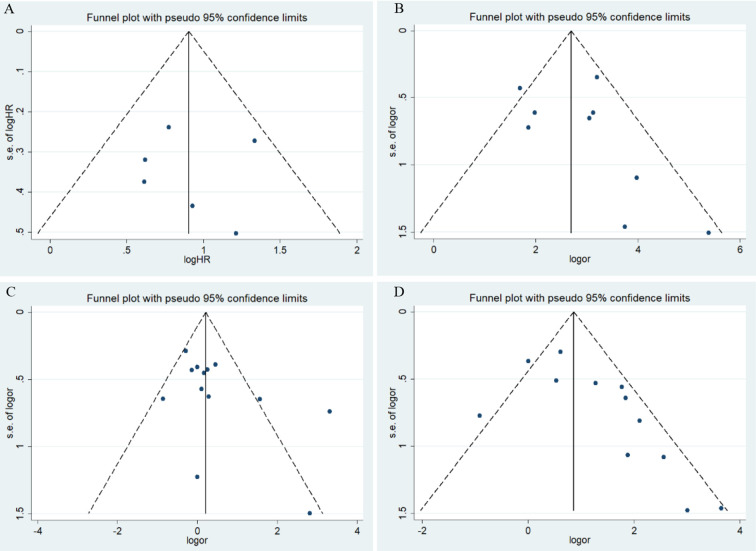
Funnel plots for the association of risk, clinical features, and overall survival in endometrial cancer with HIF-1α expression. OR, odds ratio; CI, confidence interval; (A) overall survival in endometrial cancer; (B) risk of endometrial cancer; (C) stage of endometrial cancer; (D) lymphatic metastasis of endometrial cancer.